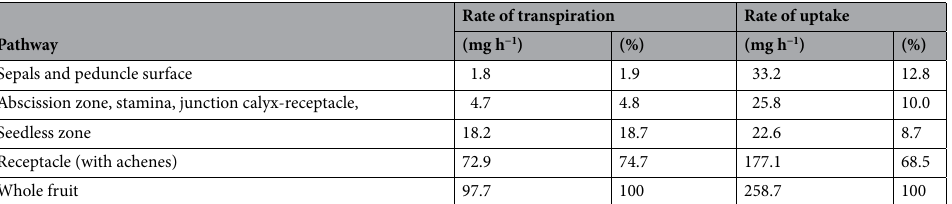
Rate of transpiration Rate of uptake (mg h −1 ) (%) (mg h −1 ) (%)